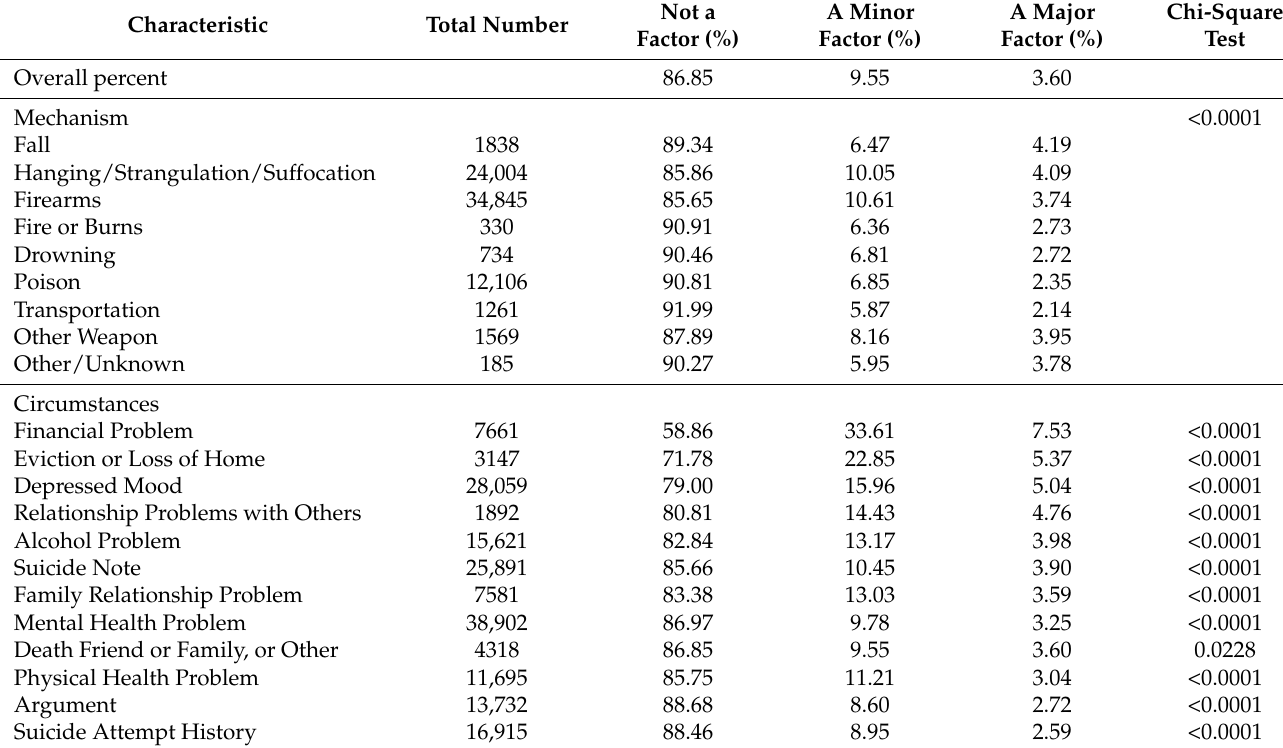
Table 3. Proportion of suicides for which work was a minor, major, or not a contributing factor, by mechanism and circumstances, National Violent Death Reporting System, 2013 through 2017